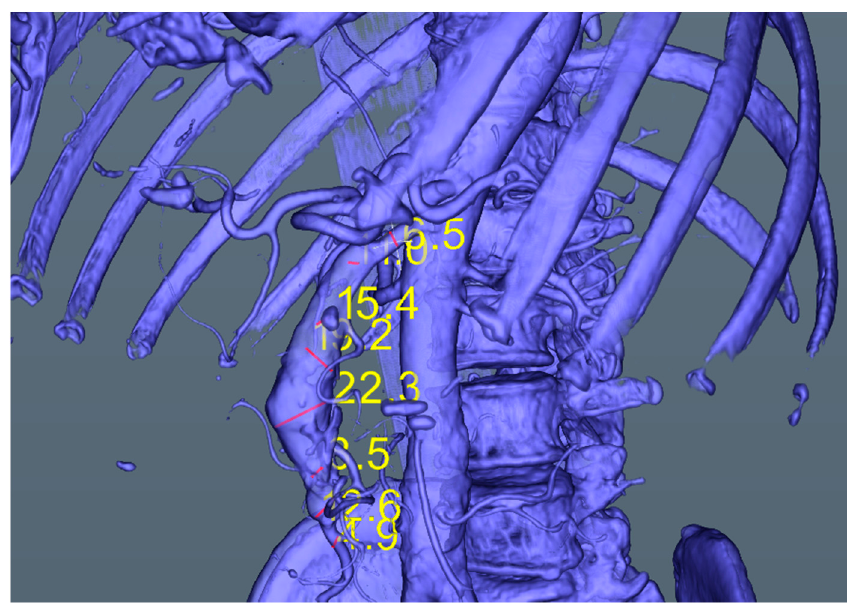
Figure 7. Virtual angiography trajectory—“procedure” started opposite to the blood flow, bottom- up, with the final point into the aorta (direction is opposite to the blood flow).